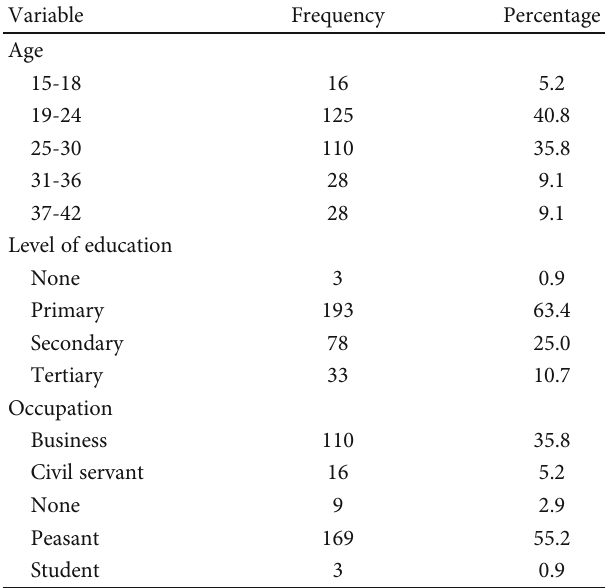
Table 1: Sociodemographic characteristics, N = 307